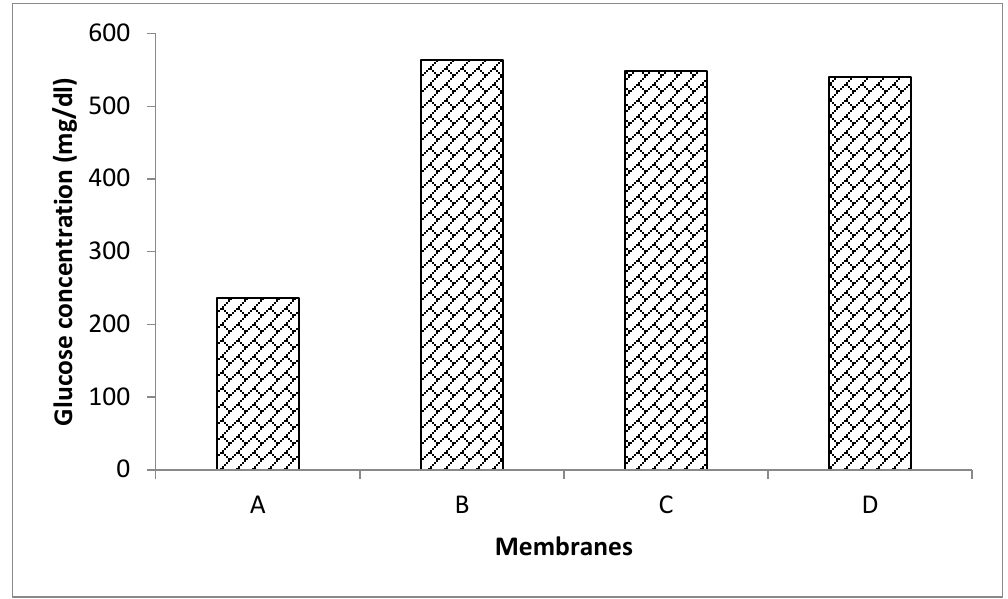
Figure 4. Concentration of glucose units released through the biodegradation of κ -carrageenan-starch membranes using amylase enzyme. ( A ): plain κ -carrageenan, ( B ): κ -carrageenan: starch (1:1), ( C ): κ -carrageenan: starch (2:1), and ( D ): κ -carrageenan: starch (1:2).